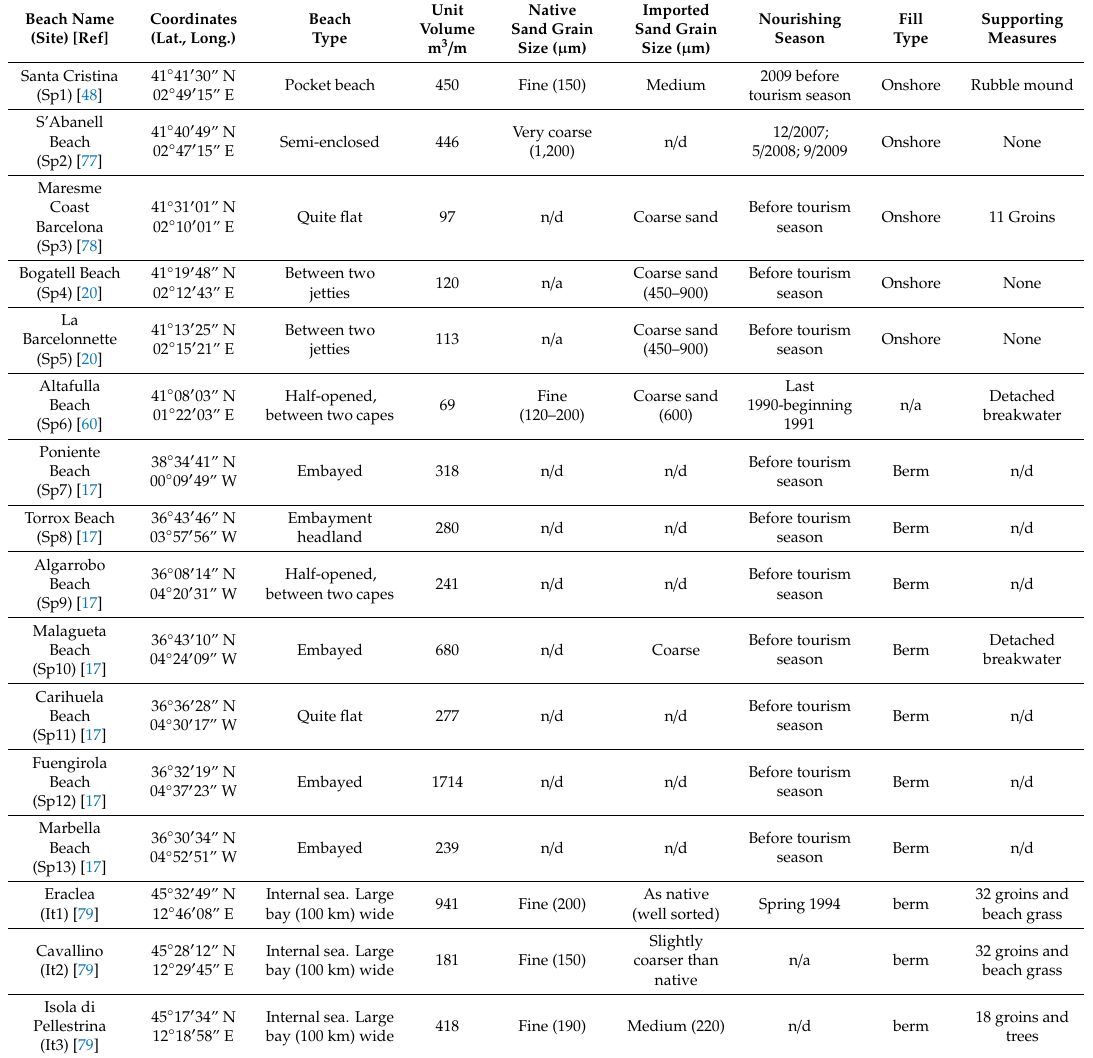
Table A1. Selected beach nourishment sites along the Mediterranean coast of Spain (Sp1–Sp12), France (Fr1–Fr4), Italy (It1–It12) (Figure 8), and Israel (Figure 1): Physical characteristics and main nourishment factors. (n / d: no